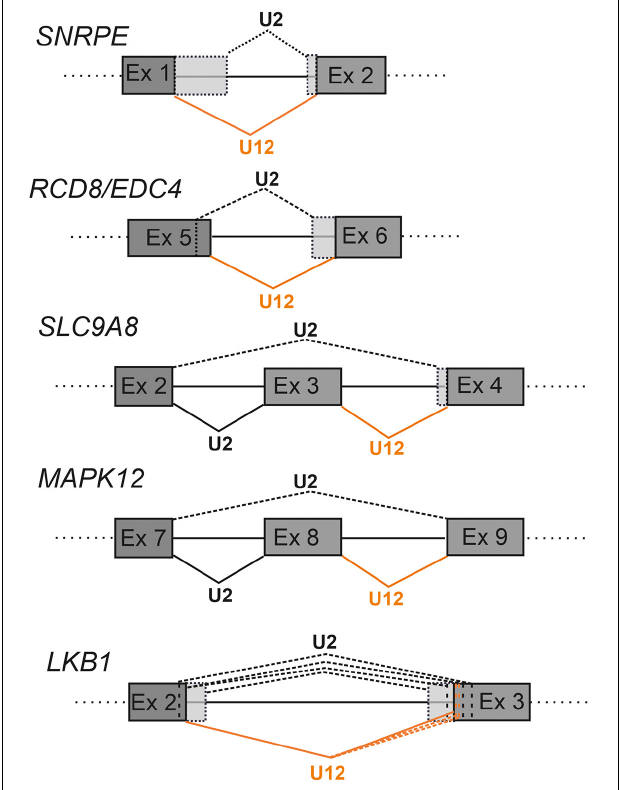
FIGURE 4 | Schematics showing examples of cryptic splice site activation in defective minor intron splicing. The U2-type splicing is indicated with black lines and U12-type splicing with orange lines. Constitutive splicing is indicated with solid lines and cryptic splicing with dotted lines. Alternative exon sequences are indicated with light gray shading. With LKB1 the additional cryptic splice sites are indicated by dotted vertical